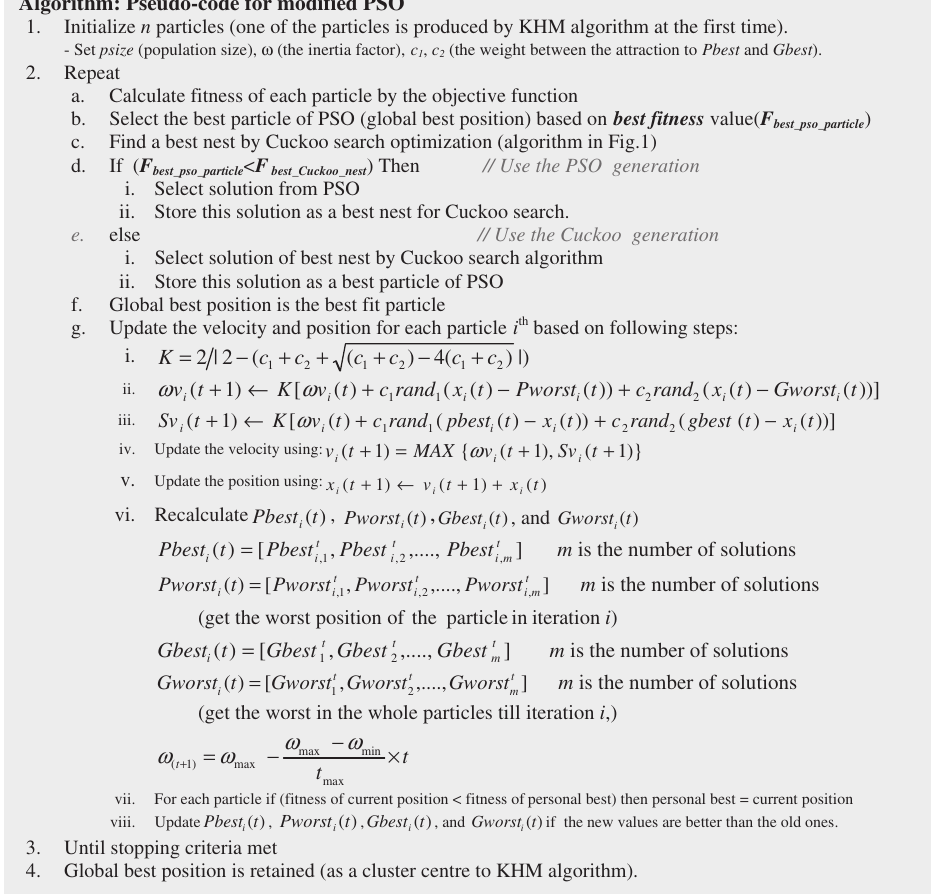
Figure 3: Pseudo-code of the Modified PSO